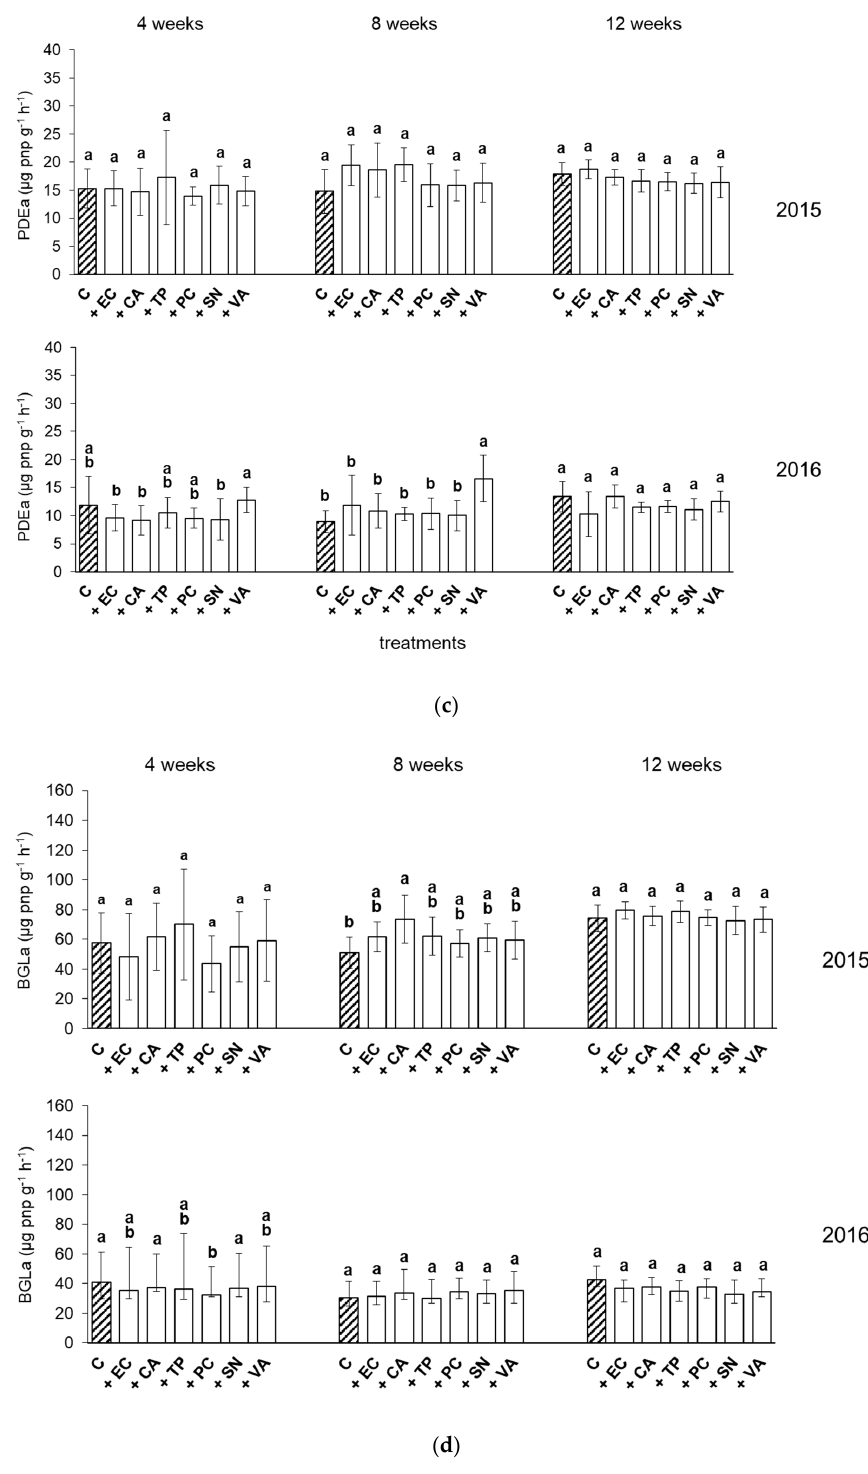
Figure 4. Activity of acid (ACPa, a ), alkaline phosphomonoesterases (ALPa, b ), phosphodiesterase (PDEa, c ) and beta glucosidase (BGLa, d ) in soil (µg pnp g − 1 h − 1 ) in weed-free growth ( c ) and mixed growth with weeds in dependence of the growth stage in a pot experiment (6 kg of a P deficient loamy sand per pot) under semi field conditions in 2015 and 2016. Values are expressed as means ± SD. Lower letters indicate significant differences ( p < 0.05, Tukey test, n = 42). (C: control, +EC: maize + Echinochloa crus-galli, +CA: maize + Chenopodium album , +TP: maize + Tripleurospermum perforatum , +PC: maize + Polygonum convolvulus , +SN: maize + Solanum nigrum , +VA: maize + Viola arvensis